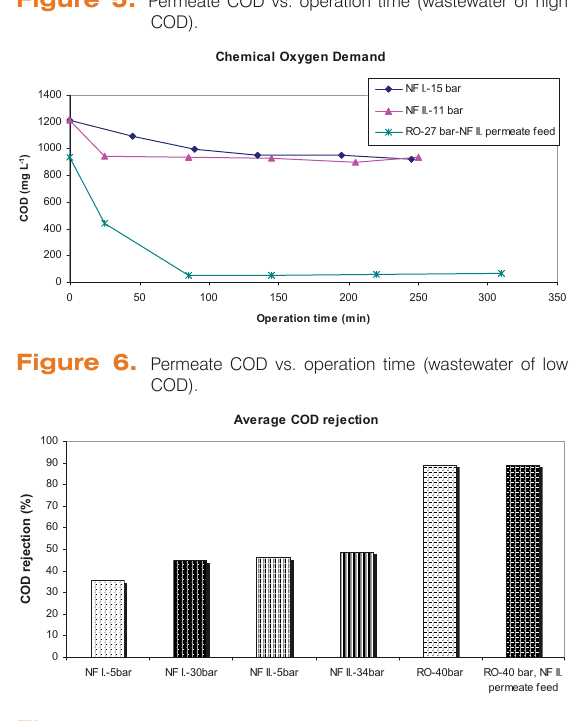
Figure 7. Average COD rejection of the applied membranes in case of pharmaceutical industry (wastewater of high COD).